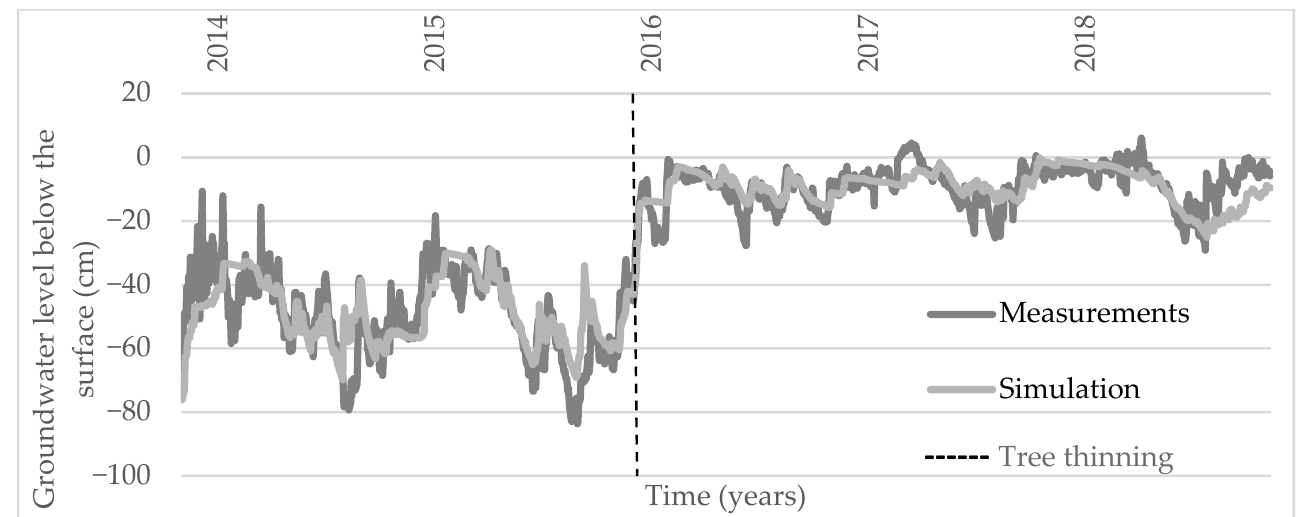
Figure 7. Measured vs. simulated groundwater level in plot 4.